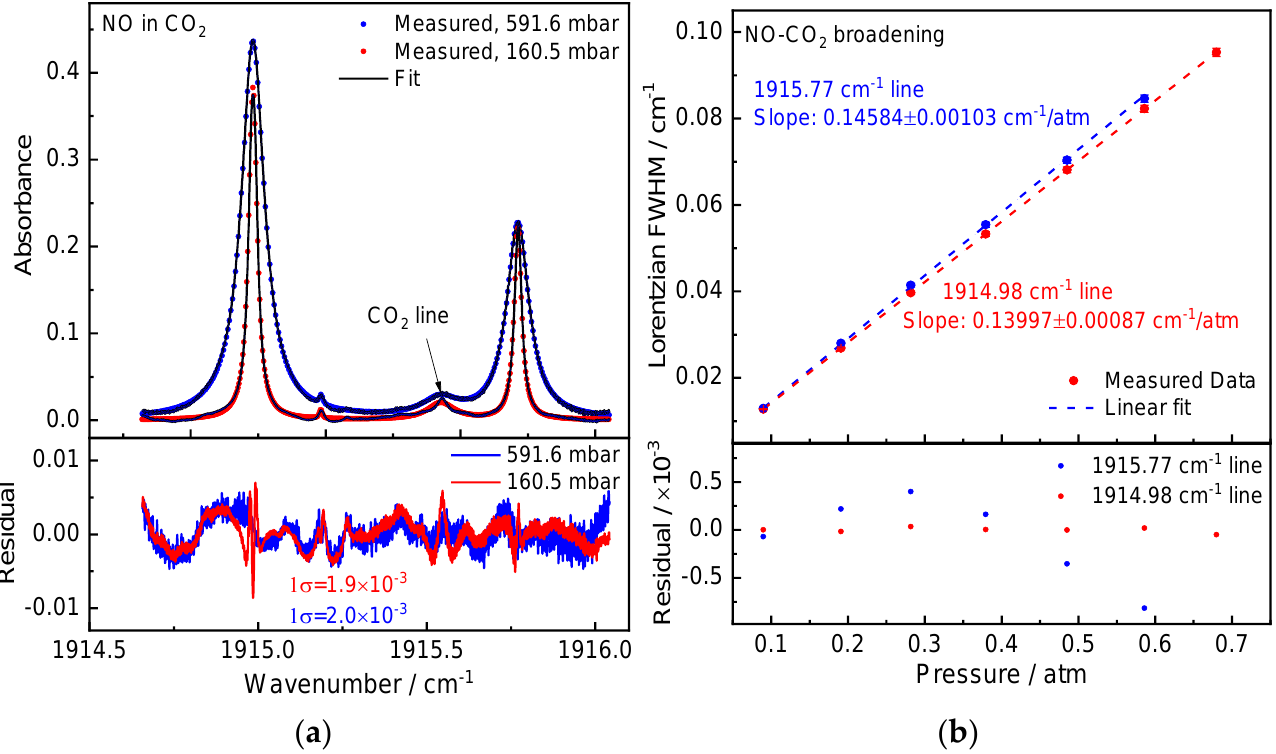
Figure 2. ( a ) Measured NO absorption spectra (averaged over 20 scans) in CO 2 at pressures of 160.5 mbar and 591.6 mbar. Below is a display of the residual between the measured and fitted values. ( b ) A linear fitted model utilized to measured CO 2 -induced pressure broadening of two NO absorption peaks. Shown below are the residual between fit and data.